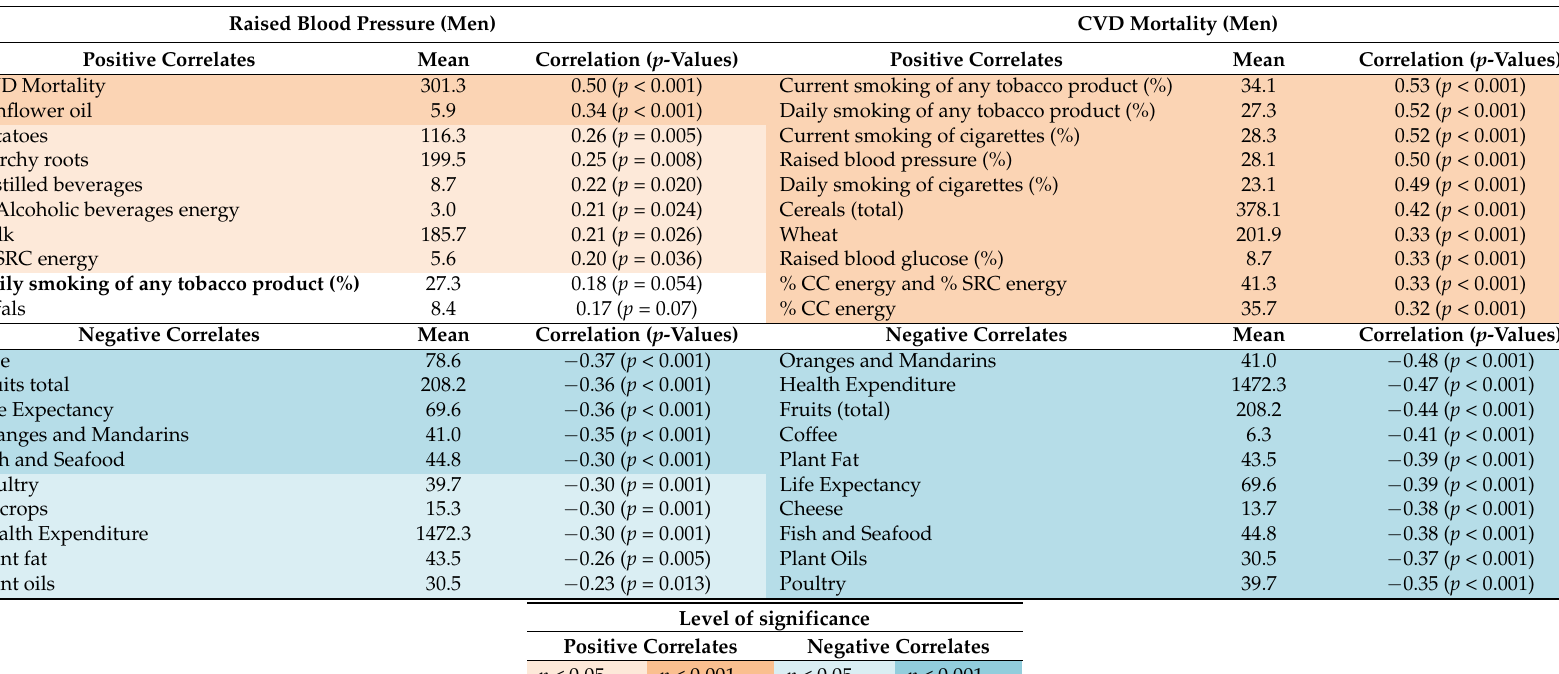
Table 7. Relationship between men’s raised blood pressure, CVD mortality and the examined variables, including smoking prevalence (115 countries).